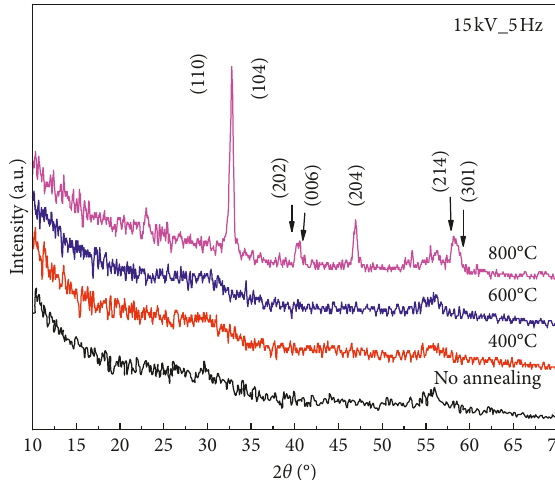
Figure 5: XRD patterns of the LaMnO 3 target made of LaMnO 3 and after annealing at 400 ° C, 600 ° C, and 800 ° C with a discharging voltage of 15kV.